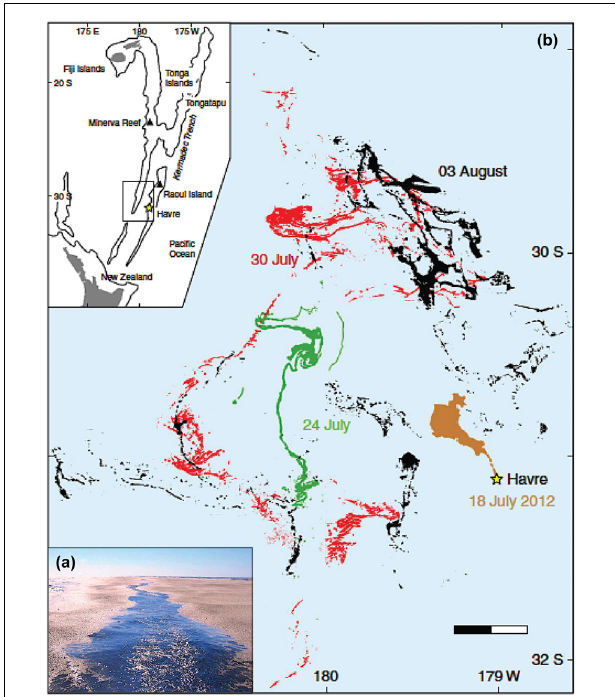
FIGURE 10 | (a) Raft of pumice clasts resulting from the Home Reef volcano eruption from 7 to 16? August 2006, Tonga volcanic arc, southwest Pacific. Source: NOAA; Photo taken by Fredrik on the yacht Maiken, August, 17, 2006. (b) Drift pattern of the pumice raft resulting from the July 18, 2012 submarine eruption of the submarine Havre volcano in the Kermadec volcanic arc depicted on different dates after the eruption. (From Jutzeler et al., 2014, Figure 1 , Nature Communications, without change except for part (a) inserted, under Creative Commons Attribution 3.0 Unported License CC by